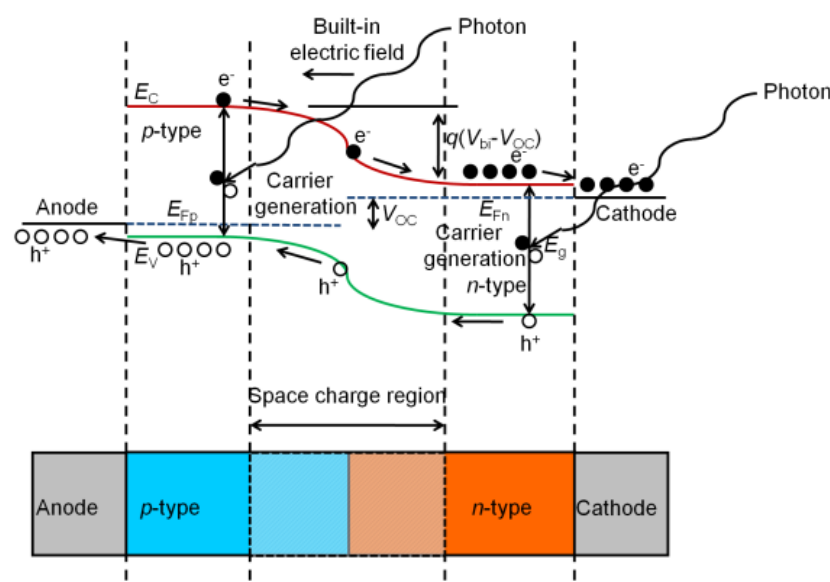
Figure 1. Energy-band diagram of a silicon p-n junction solar cell (Reproduced with permission from [8], Li Y.,